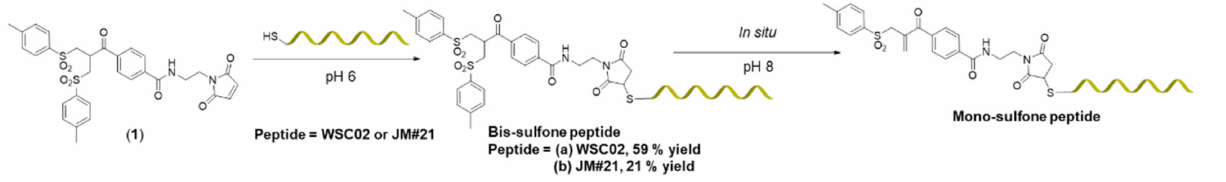
Figure A1. Syntheses of bis-sulfone peptides (WSC02 or JM21) and generation of mono-sulfone peptide through in situ elimination at alkaline pH (pH = 8).